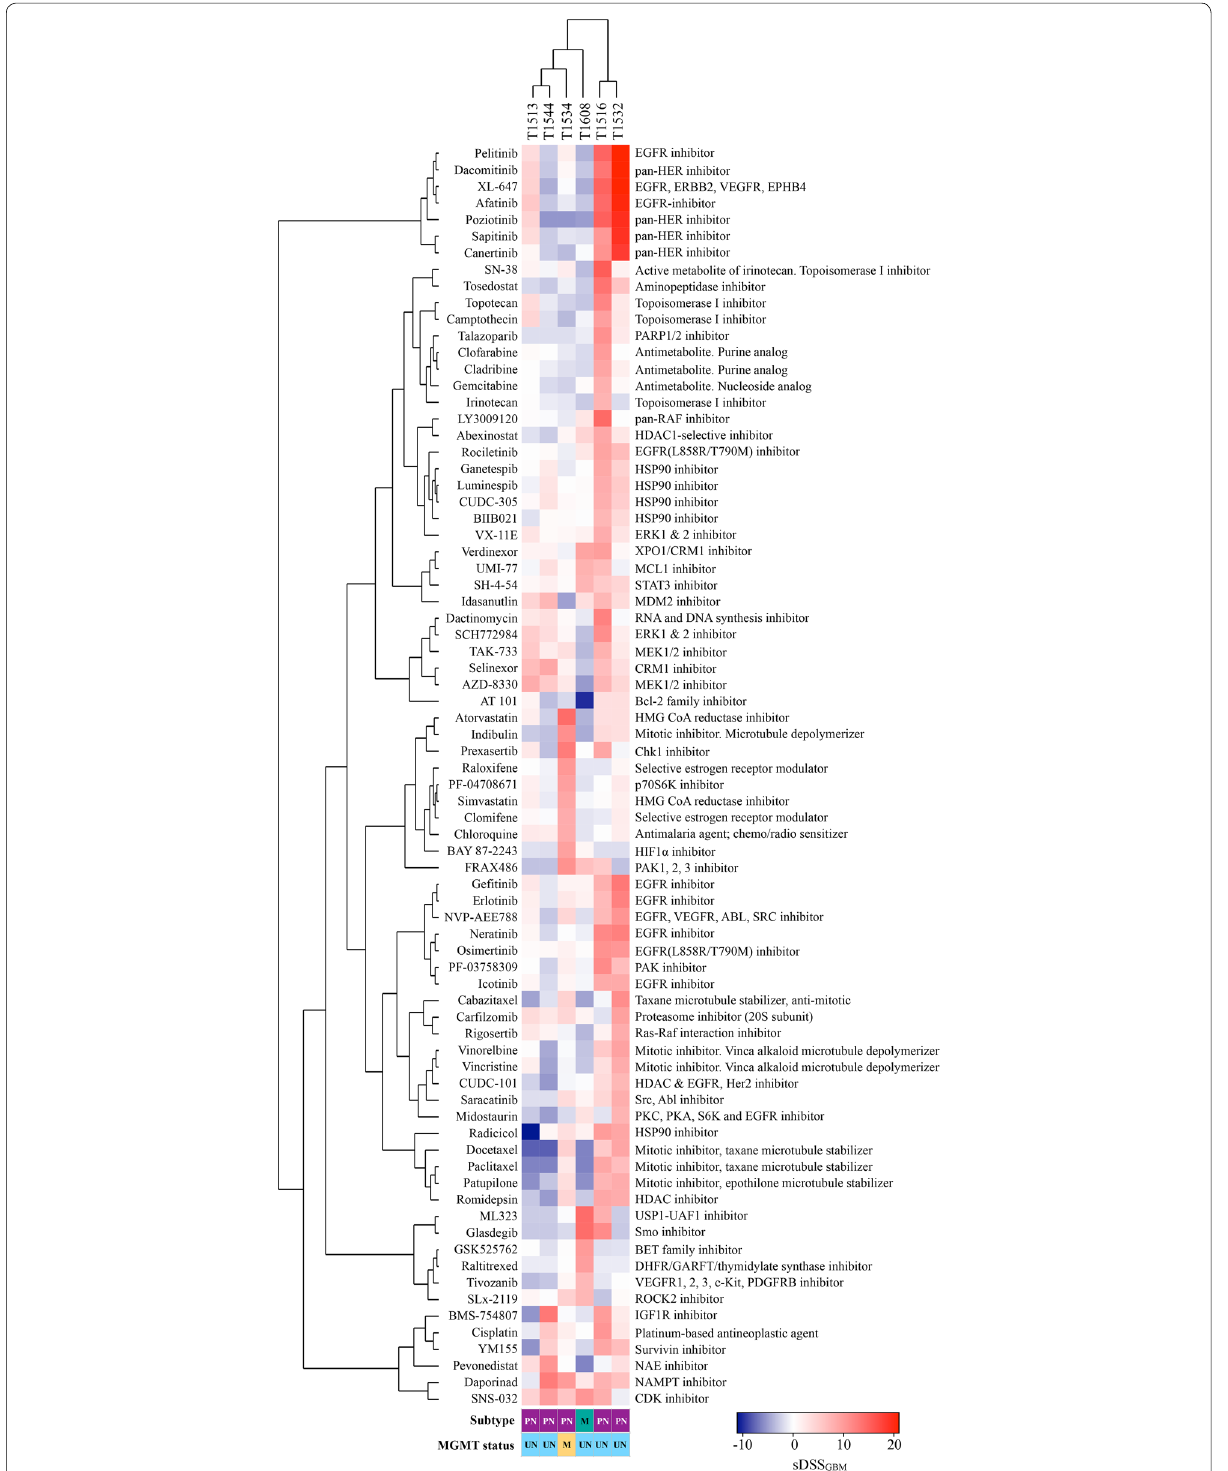
Fig. 4 Unsupervised hierarchical clustering of drug sensitivity patterns in recGBM. Heat map and unsupervised hierarchical clustering of patient‑specific drug responses (sDSS GBM ) with Euclidian distance (cultures and drugs). The heat map is filtered by DSS (n 76 drugs). PN proneural, M mesenchymal, UN unmethylated MGMT promoter, ME methylated MGMT =